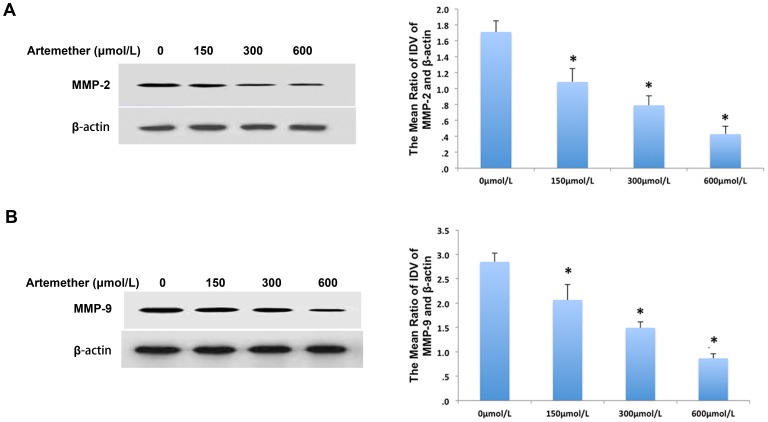
Artemether down-regulated the expression of MMP-2 and MMP-9 in U87 cells.U87 cells were treated with atemether at various concentrations (0 µmol/L, 150 µmol/L, 300 µmol/L and 600 µmol/L) for 48 h and Western Blot assay was utilized to check the changes of MMP protein expressions. (A) The effects of atemether on MMP-2 expression in U87 cells. (B) The effects of atemether on the expression of MMP-9. The concentrations of 150 µmol/L, 300 µmol/L and 600 µmol/L significantly inhibited the expression of MMP-2 and MMP-9 proteins compared with 0 µmol/L (*P<0.01). n = 4.